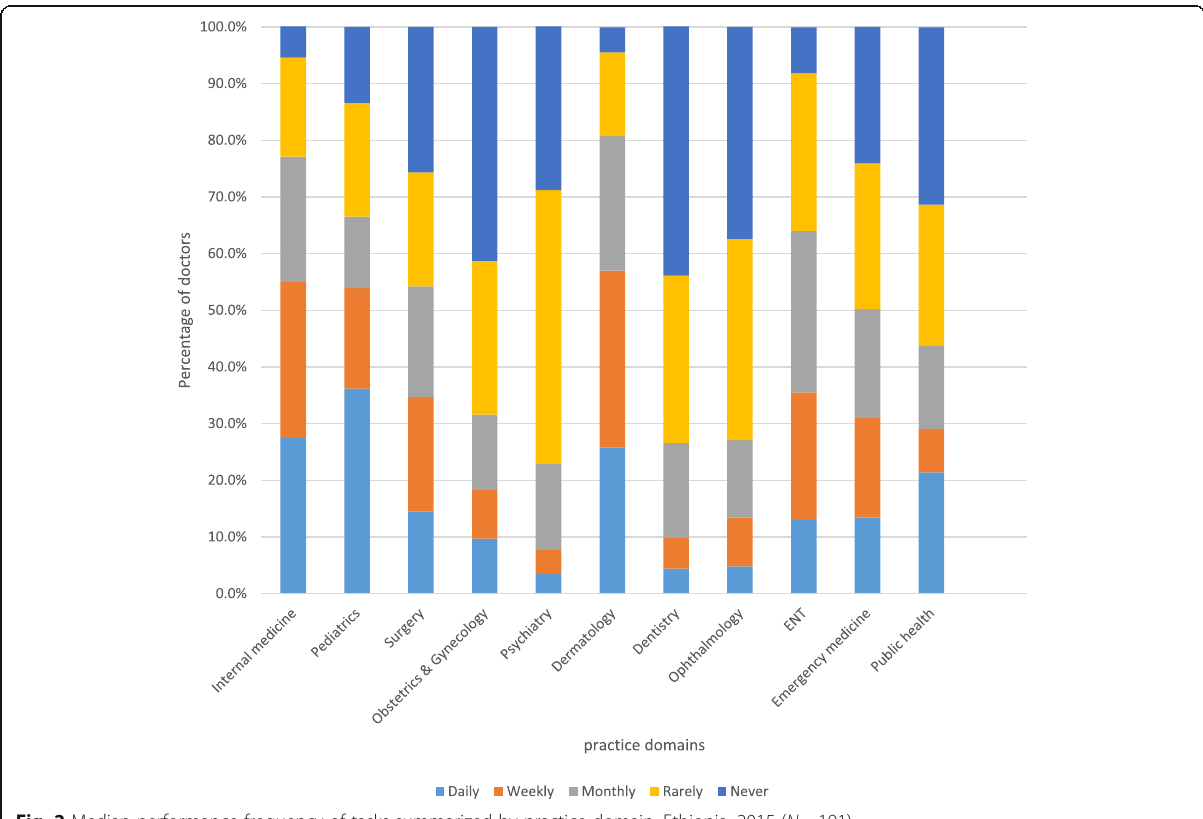
Fig. 2 Median performance frequency of tasks summarized by practice domain, Ethiopia, 2015 ( N =